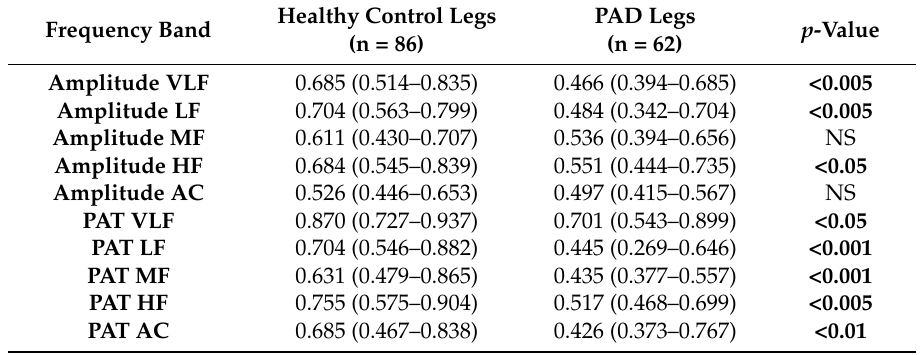
Table 4. Magnitude squared coherence (MSC) analysis using resampled normalized amplitude and PAT frequency data for the toe site. Median (IQR) values are shown. NS: Non-significant.